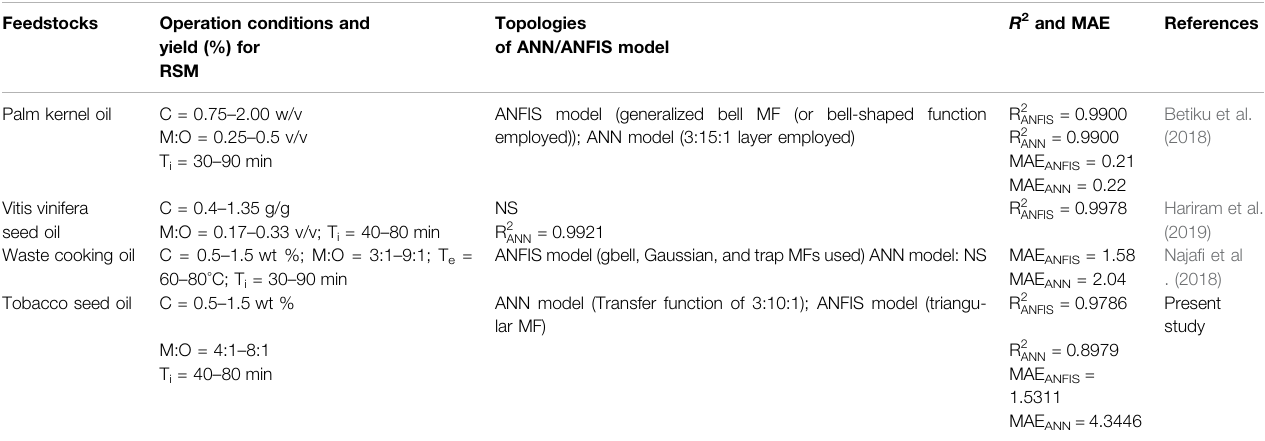
TABLE 5 | Hybrid model of TSOME.